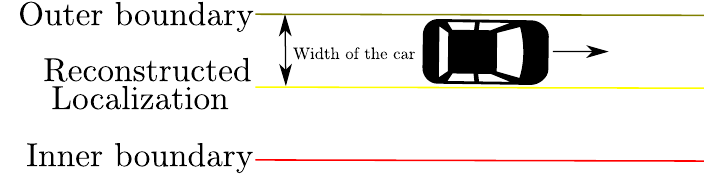
Figure 4. Approximation of vehicle position (in Yellow) in between lanes using lane dimensions of the selected test-region obtained from HD map and vehicle width